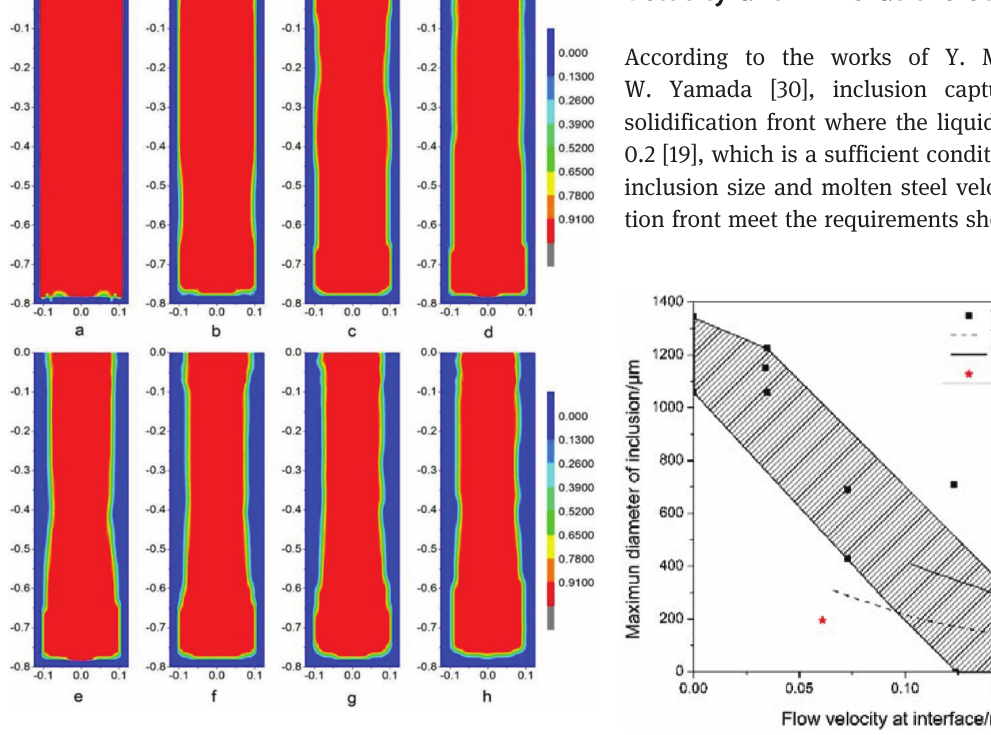
Figure 3: Liquid fractions at different slab cross sections: 0.1m (a) 0.2m (b) 0.3m (c) 0.4m (d) 0.5m (e) 0.6m (f) 0.7m (g) 0.8m (h) from the meniscus.